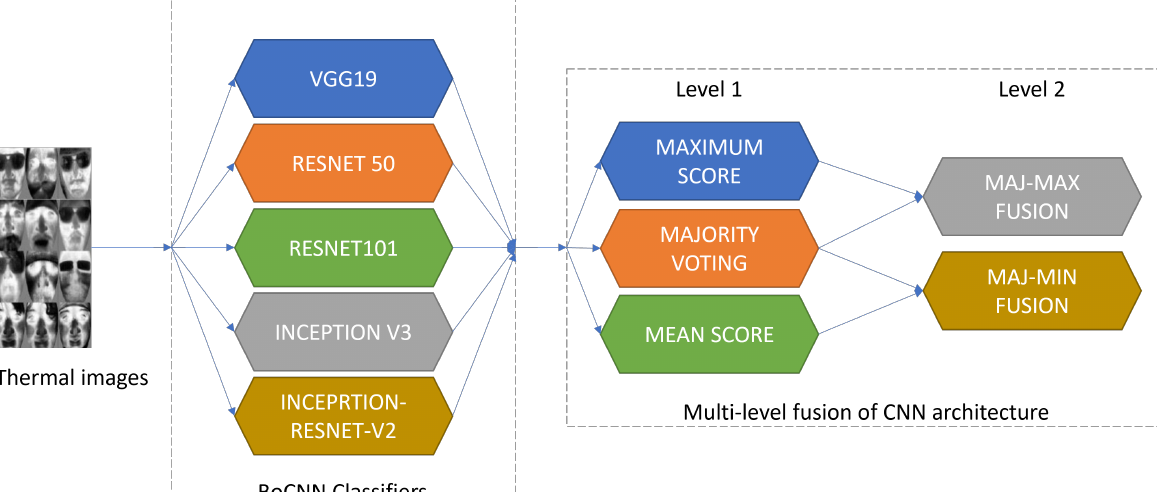
Figure 14. The BoCNN architecture proposed in